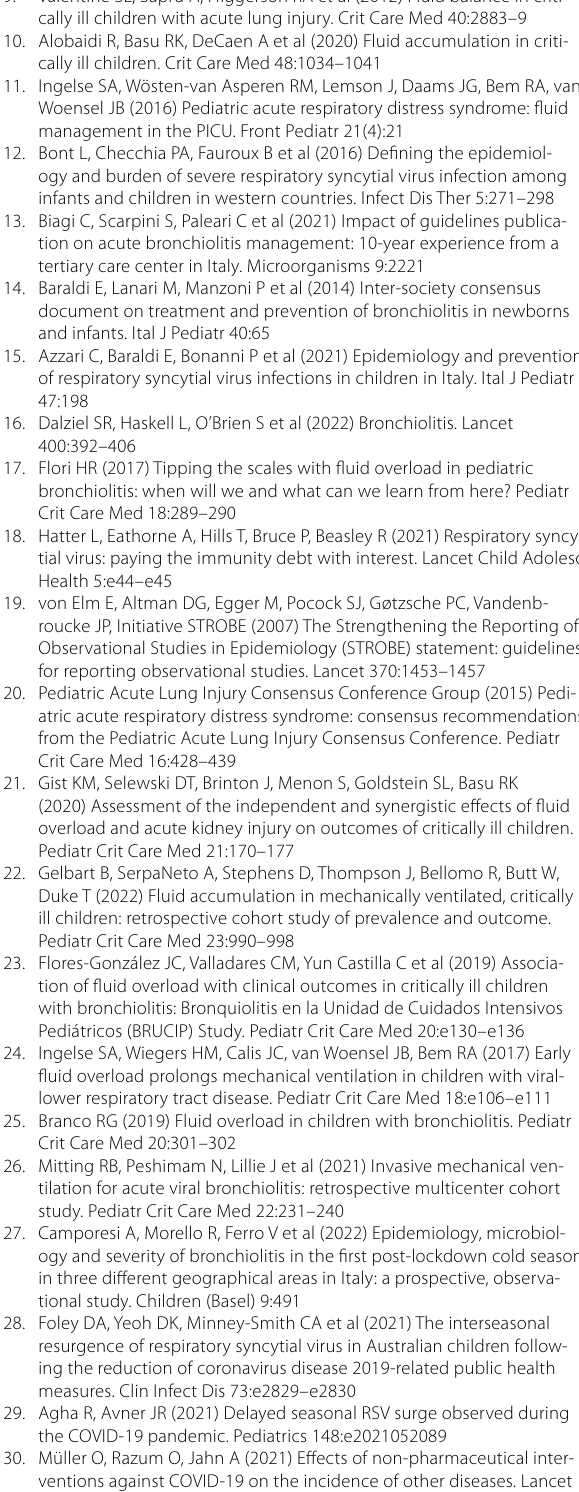
Supplementary Table S2. Correlation of different subgroups with fluid balance from day 1 to day